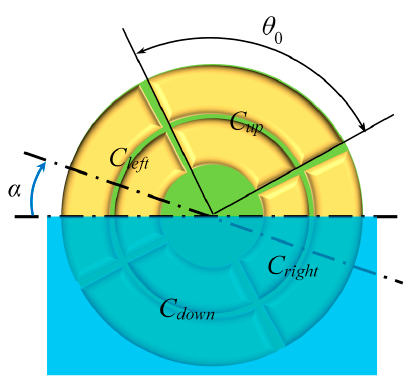
Figure 6. Schematic view of a tilt sensor with four segmented concentric annular coplanar capacitors.